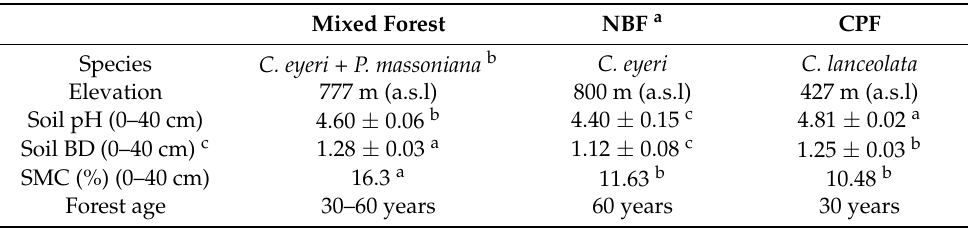
Table 1. Characteristics of the study area and selected forest types. Values are mean ± SE. Different small letters represent the significant difference among forest types at p ≤